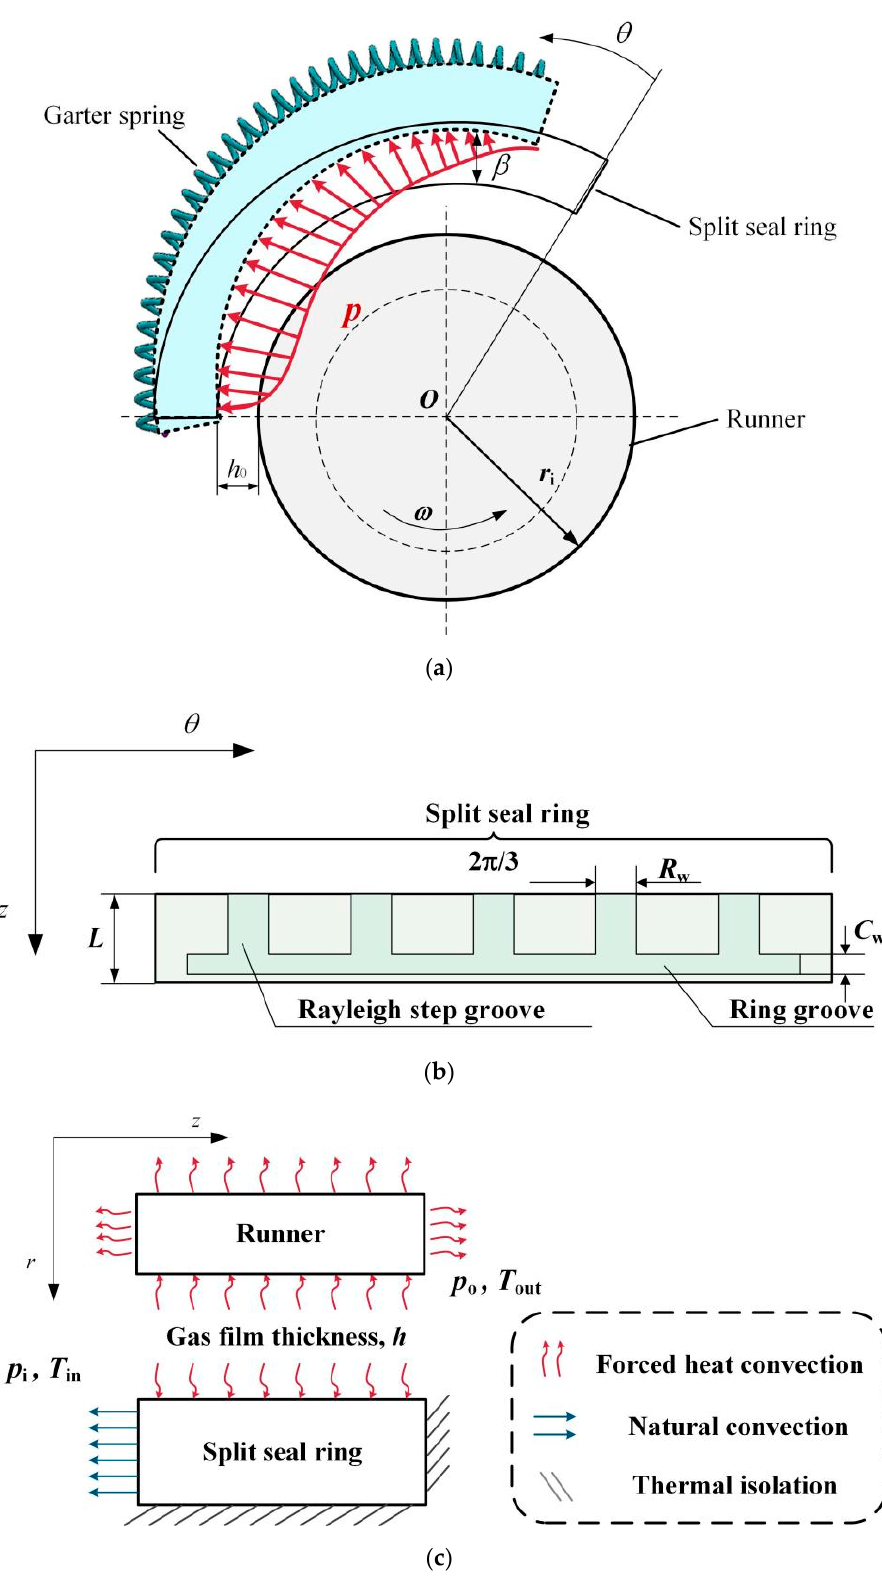
Figure 1. Schematic diagram of split floating ring seal structure and heat transfer boundary [2]. ( a ) Split floating ring seal structure; ( b ) Schematic diagram of Rayleigh step groove structure; ( c ) Boundary conditions.